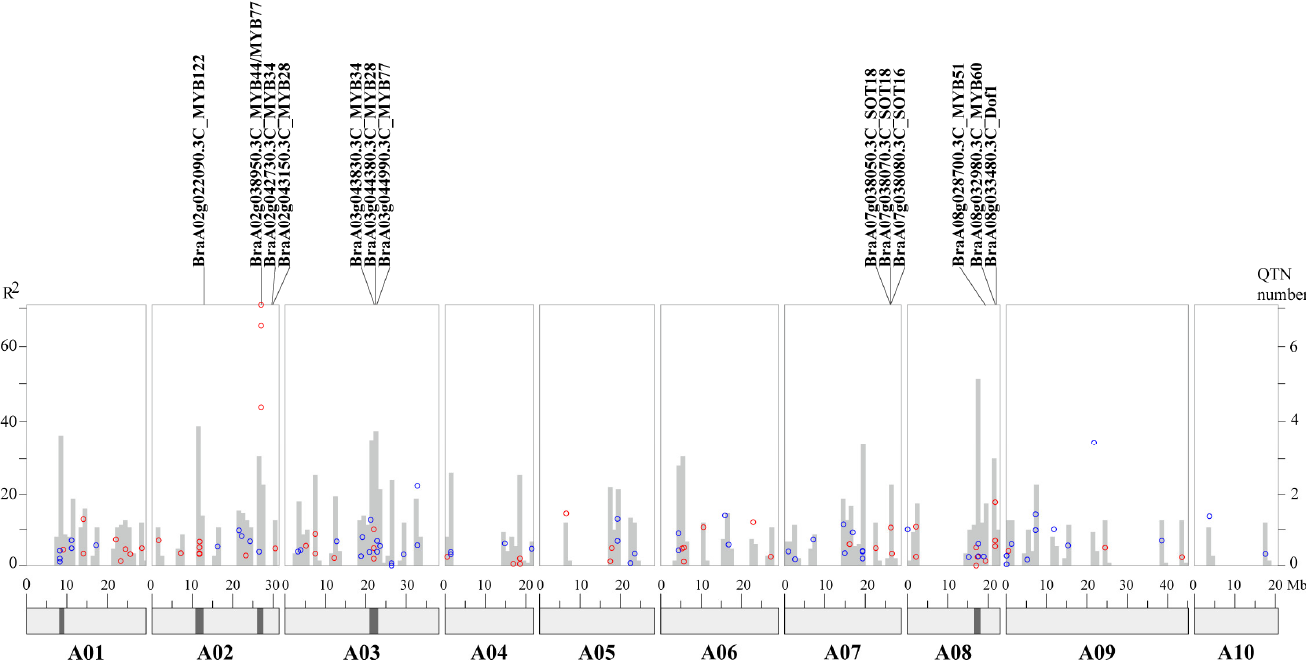
Figure 2. Distribution of QTNs for two Phe-derived GSLs by mGWAS in B. rapa . The red and blue dots indicate QTNs for benzylGSL and phenethylGSL, respectively. The gray bar indicates the numbers of detected QTNs on the chromosomes. The black of the chromosomes indicate five hot regions where QTNs gathered. R 2 indicates the phenotypic variations explained by QTNs.